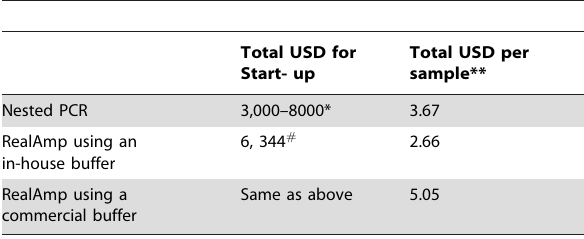
Table 2. Sensitivity and Specificity of the RealAmp method and nested PCR compared to microscopy.